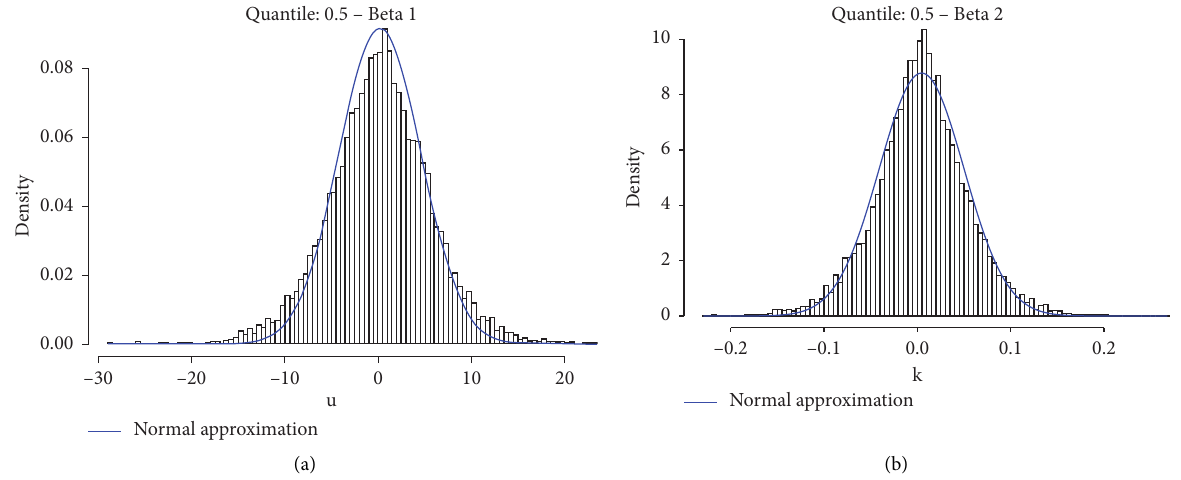
Figure 7: Posterior histograms for quantile regression: (a) curvature friction coefficient µ; (b) wobble friction coefficient